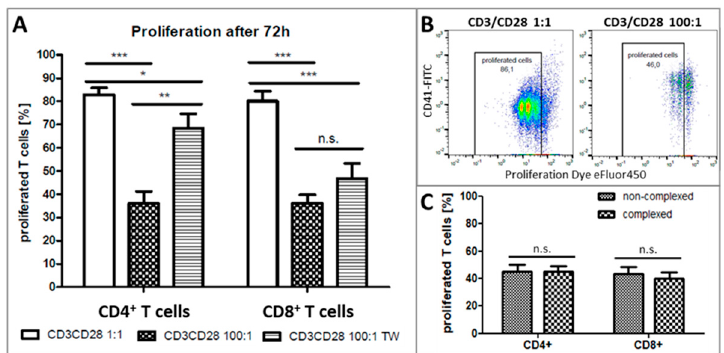
Figure 5. Proliferation of T cells from healthy donors after 72 h anti-CD3 and anti-CD28 stimulated culture. ( A ) Flow cytometric analysis of the percentage of proliferated CD4 + or CD8 + T cells. Cells were cultured in a PLT: PBMC ratio of 1:1, 100:1 (direct contact) or 100:1 in Transwell Assays (TW). Bars depict mean + SEM of results from 20 healthy donors. n.s. p ≥ 0.05; * p ≤ 0.05; ** p ≤ 0.01; *** p ≤ 0.001;